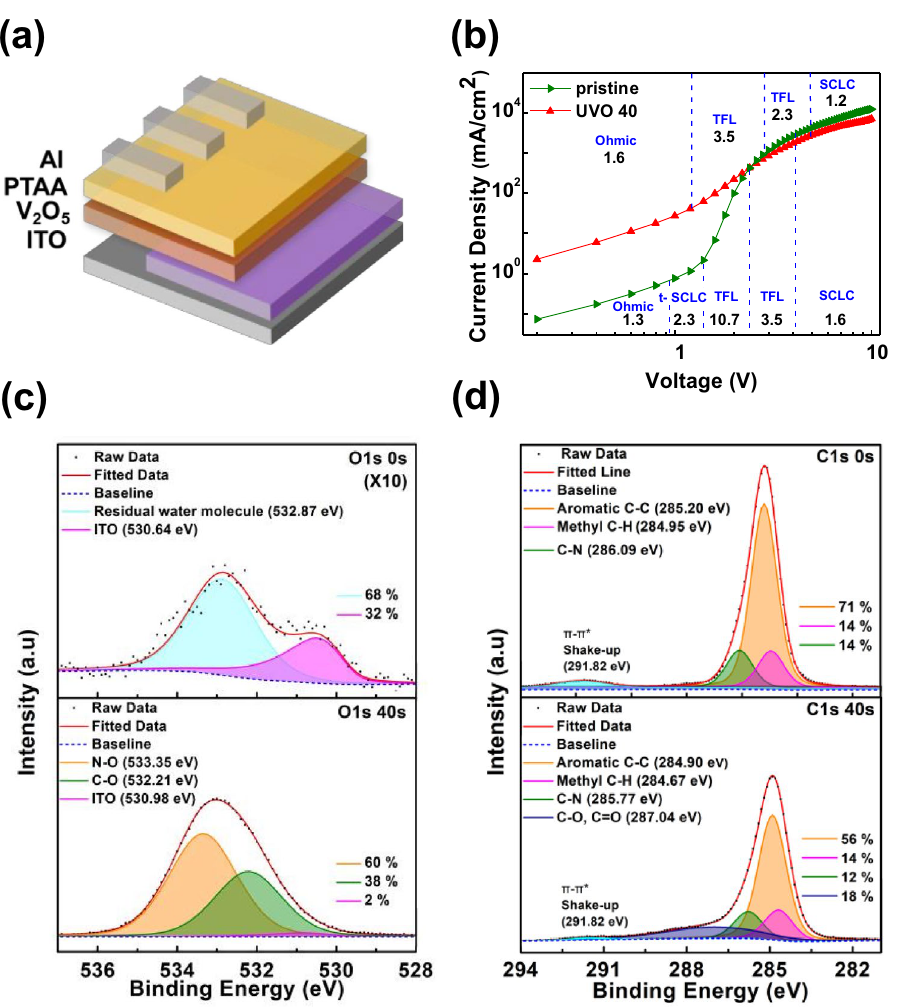
Figure 3. ( a ) Schematic structure of the HOD with PTAA HTL. ( b ) J-V curves of the pristine HOD and HOD with UVO 40. ( c ) O 1 s and ( d ) C 1 s XPS spectra of the pristine and UVO 40 PTAA films on